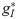
Illustration of model parameter estimation method.(a,b) Points show (a) estimated inhibition, gI*, and (b) estimated excitation, gE*, from data generated from models versus actual model inihibition, gI, for various actual model excitation, gE (see key). (c) Points show the estimated excitation, gE*, versus estimated inhibition, gI*, for data generated from models. Colour (see key) shows the actual model excitation, gE. Actual model inhibition, gI, is not explicitly displayed the figure. (d) Slope of regression of estimated excitation, gE*, against estimated inhibition, gI*, for each level of actual model excitation, gE. (a,b,c) Bars show weighted standard errors in estimated quantities (see Methods). (d) Bars show error in slope (see Methods).